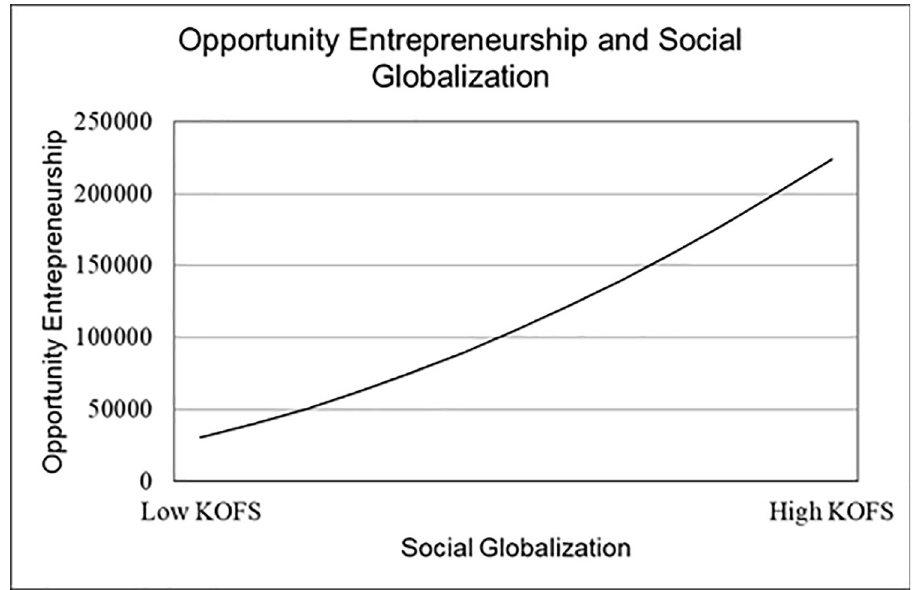
Fig 3. Quadratic fit of opportunity entrepreneurship and social